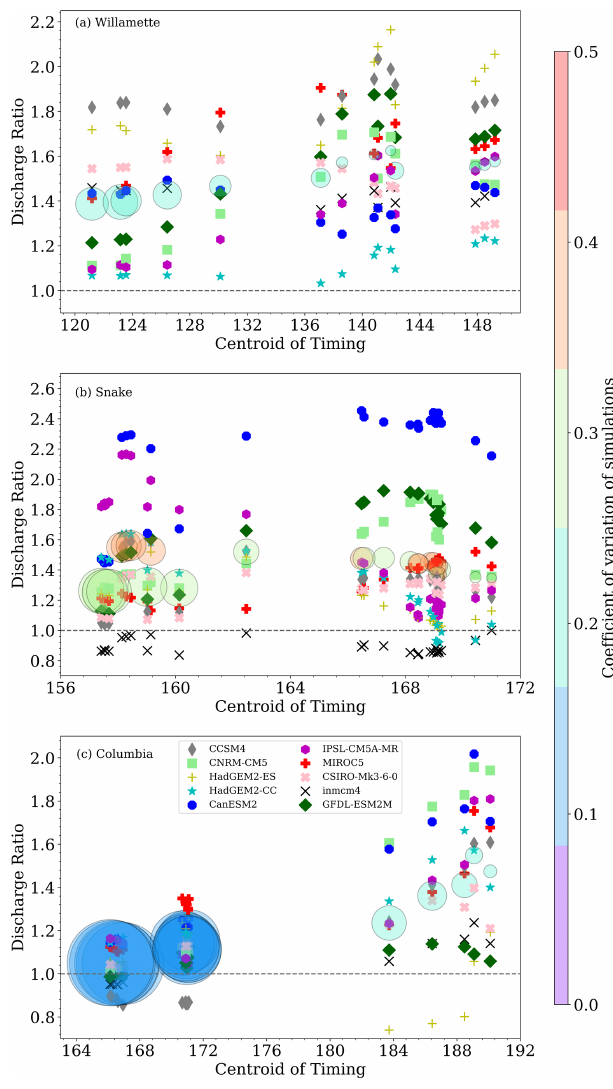
Figure 8. Average ratios of all 40 ensemble members (large cir- cles) and the average of 4 hydrologic model results for each GCM (symbols), shown for simulated streamflow locations along the Willamette River (a) , Snake River (b) , and main stem Columbia River (c) for 100-year return periods. GCMs are ordered in the leg- end by their ranking in Rupp et al. (2017), representing their ability to simulate Pacific Northwest